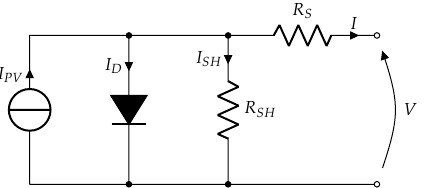
Figure 1. Equivalent circuit of single diode five-parameter